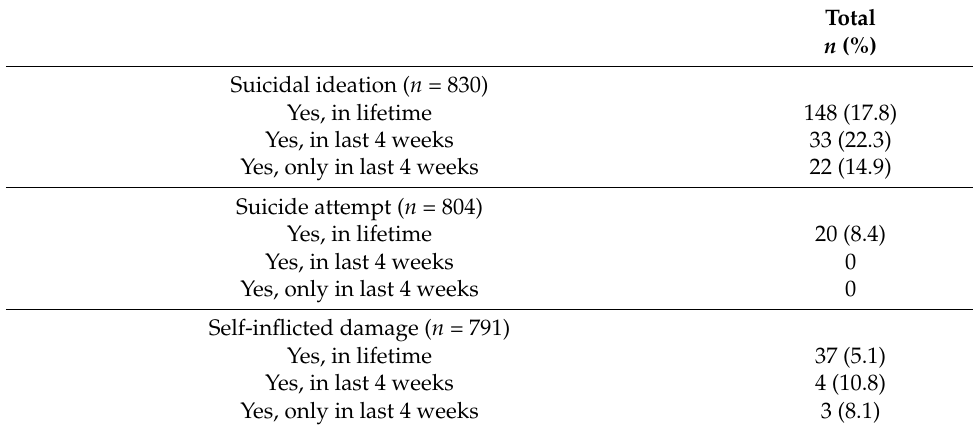
Table 4. Suicidal ideation, suicide attempts and self-inflicted damage during the first wave of